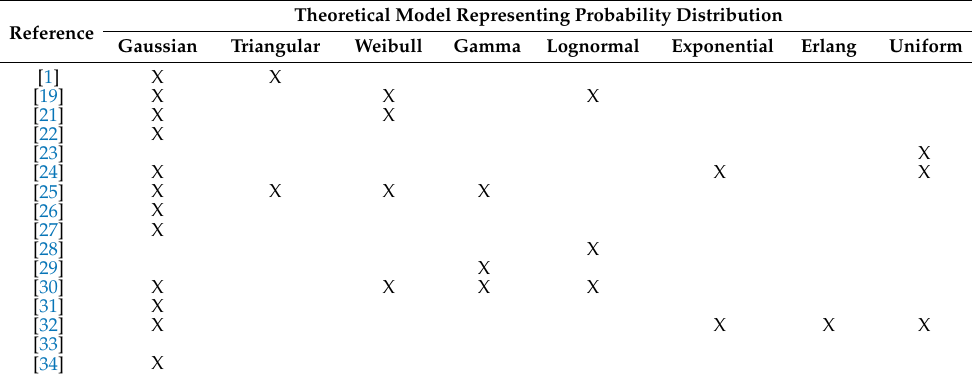
Table 1. Study cases for the stochastic approach-based truck haulage system